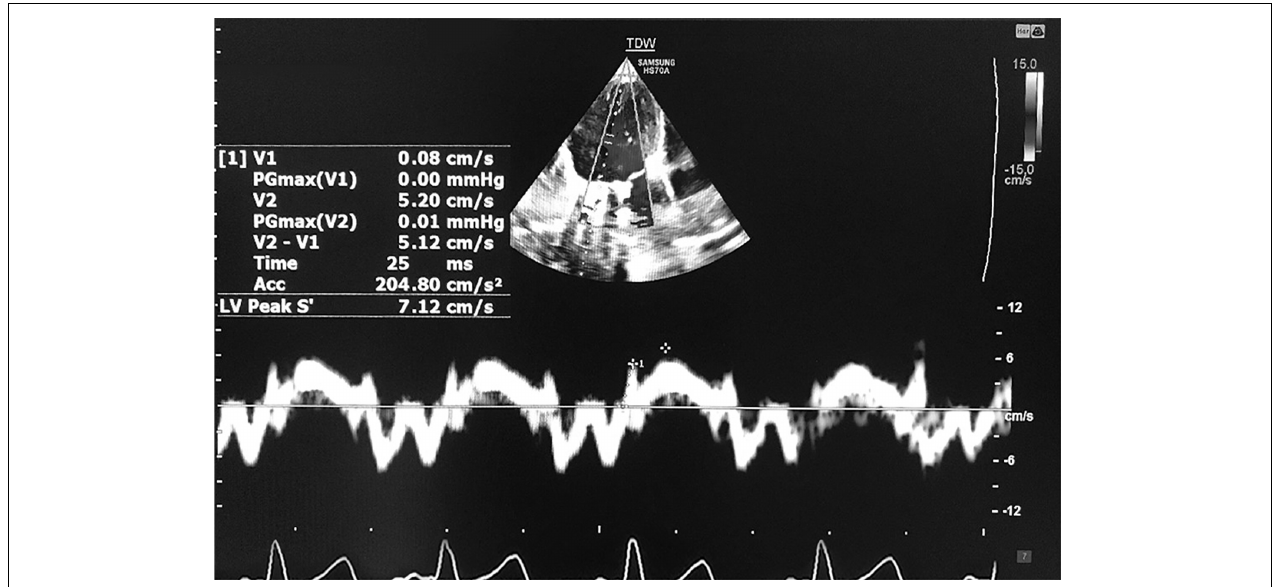
FIGURE 1 | Measurement of tissue Doppler-derived IVA and s’ velocity. IVA, myocardial acceleration during isovolumic contraction; s (cid:48) , systolic longitudinal myocardial velocity.